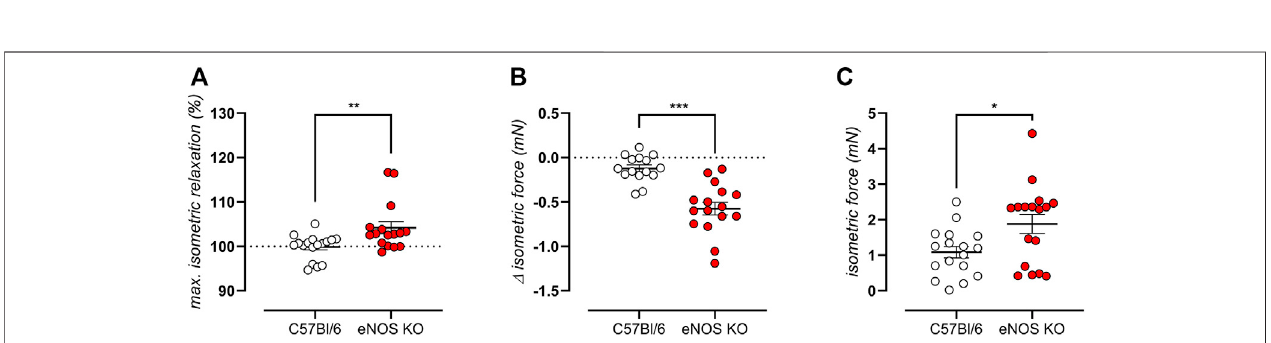
FIGURE 6 | eNOS knockout mice display high VSMC cytoplasmic calcium. VMSC intracellular calcium was studied in 6-month old eNOS knockout ( n = 16) and C57Bl/6control( n =15)mice.Increasedbaseline contractile tonewasshown asa > 100%maximal relaxation (calculated fromtheconcentration-responsecurvesusing a non-linear 4-parameter equation) upon addition exogenous NO donor DEANO (A) . Increase cytoplasmic calcium load was demonstrated as a decrease in contractile force when normal Krebs Ringer solution was replaced with a solution lacking extracellular calcium (0Ca) (B) . A baseline depolarization was shown as active isometric contraction upon addition of 30 nM BAY-K8644 in Krebs Ringer solutions (since these channels are voltage-dependent, contraction is only initiated in case of depolarization) (C) . Statistical analysis was preformed using student t -test (A,B) or Mann Whitney test (C) . *, p < 0.05; **, p < 0.01; ***, p < 0.001.